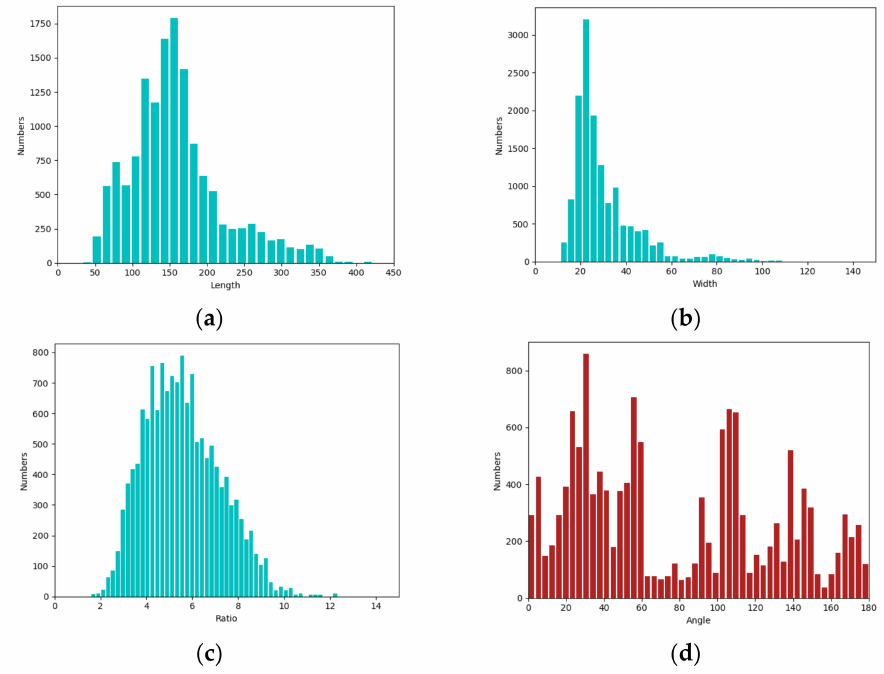
Figure 8. The distributions of the sizes, aspect ratios and angle of the oriented bounding boxes in GF-3 dataset. ( a ) Distributions of the bounding boxes’ length in GF-3 dataset. ( b ) Distributions of the bounding boxes’ width in GF-3 dataset. ( c ) Distributions of the bounding boxes’ aspect ratios in GF-3 dataset. ( d ) Distributions of the oriented bounding boxes’ angle in GF-3